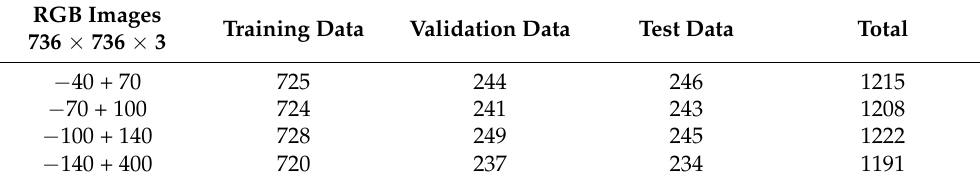
Table 2. Dataset of the sand images.